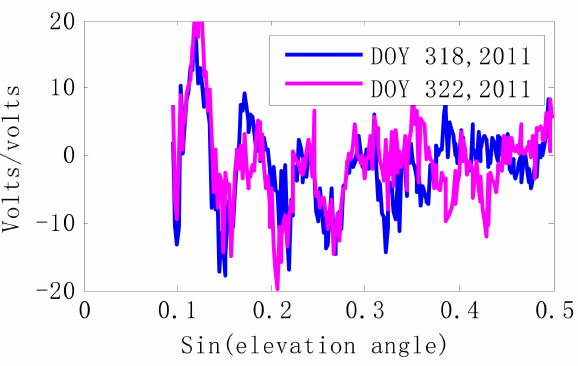
Figure 7. Observed GPS SNR data on DOY 318 (2011) (soil temperature is above 0 ◦ C) and DOY 322 (2011) (soil temperature is below 0 ◦ C). Satellite PRN =